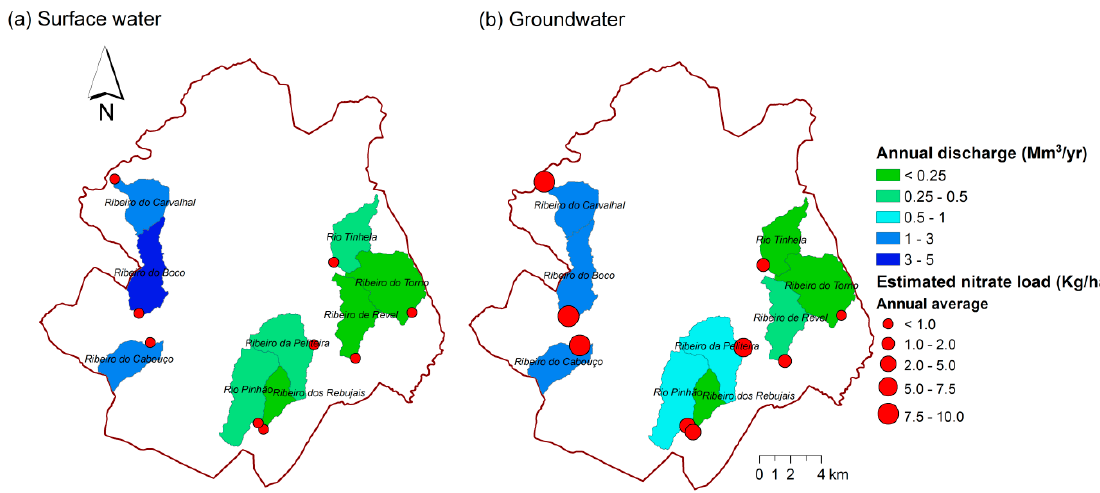
Figure 9. ArcSWAT results. ( a ) Volume of naturally discharged surface water and of corresponding nitrate load; ( b ) volume of naturally discharged groundwater and corresponding nitrate load.